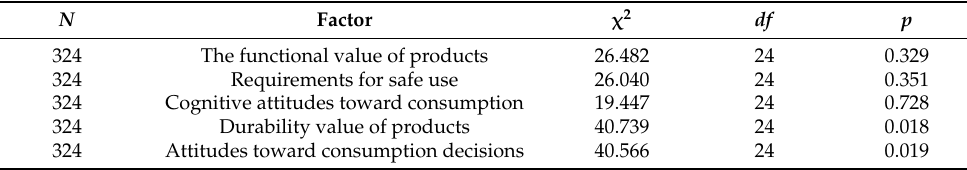
Table 11. Abstract of Chi-square tests on the dimensions and toy materials.